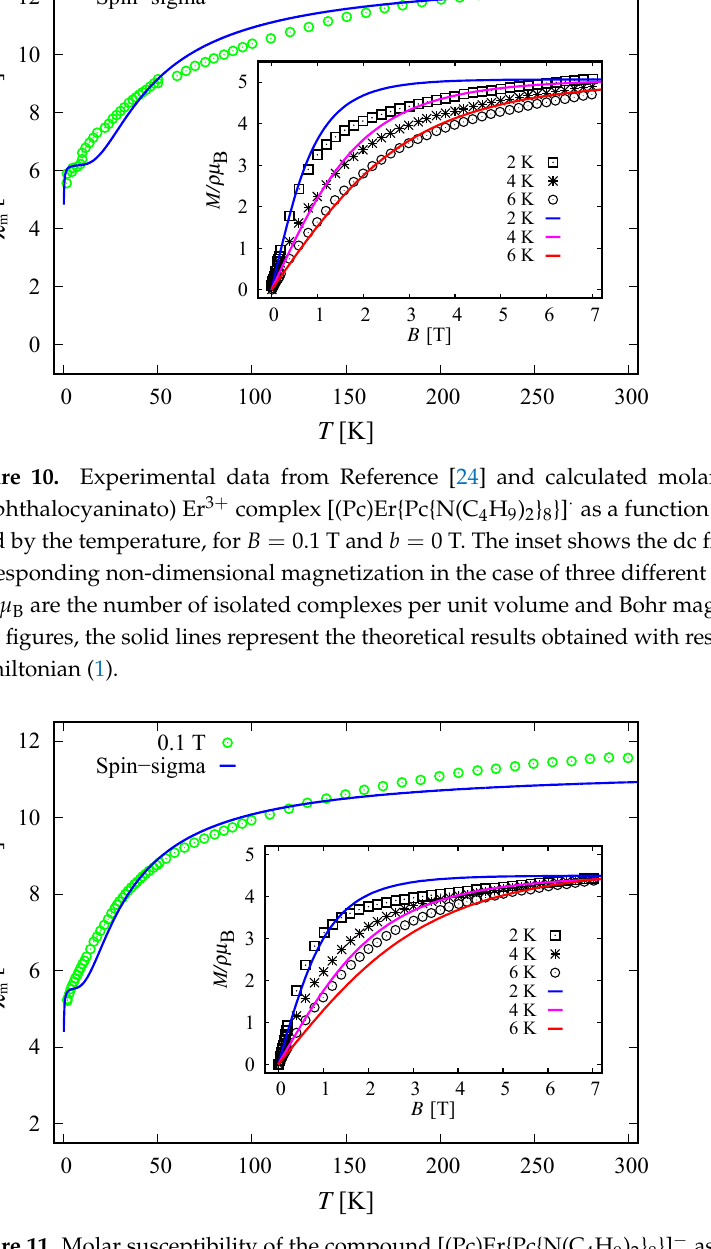
Figure 11. Molar susceptibility of the compound [(Pc)Er{Pc{N(C 4 H 9 ) 2 } 8 }] − as a function of tempera- ture, multiplied by the temperature at B = 0.1 T and b = 0 T. The inset depicts the corresponding non-dimensional magnetization as a function of the dc field for three different temperatures, with ρ and µ B designating the number of isolated complexes per unit volume and Bohr magneton, respec- tively. In both figures, the solid lines represent the theoretical results obtained with respect to the spin–sigma Hamiltonian (1). The circles, squares and stars represent the experimental data from Reference